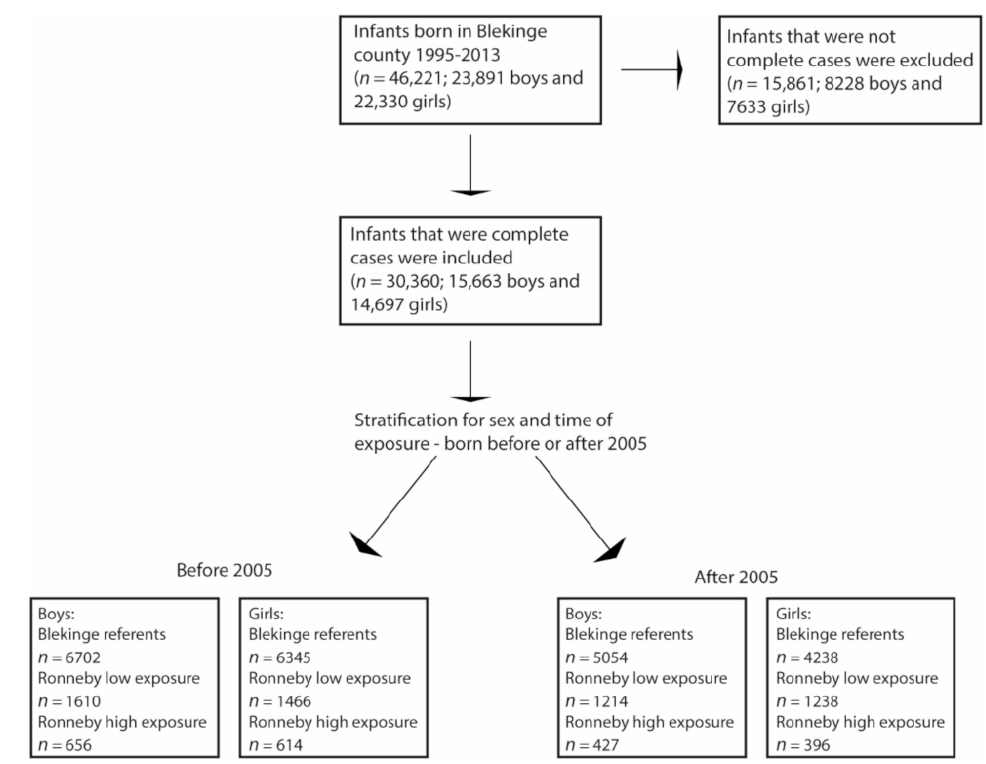
Figure 1. Flowchart of the participant selection and